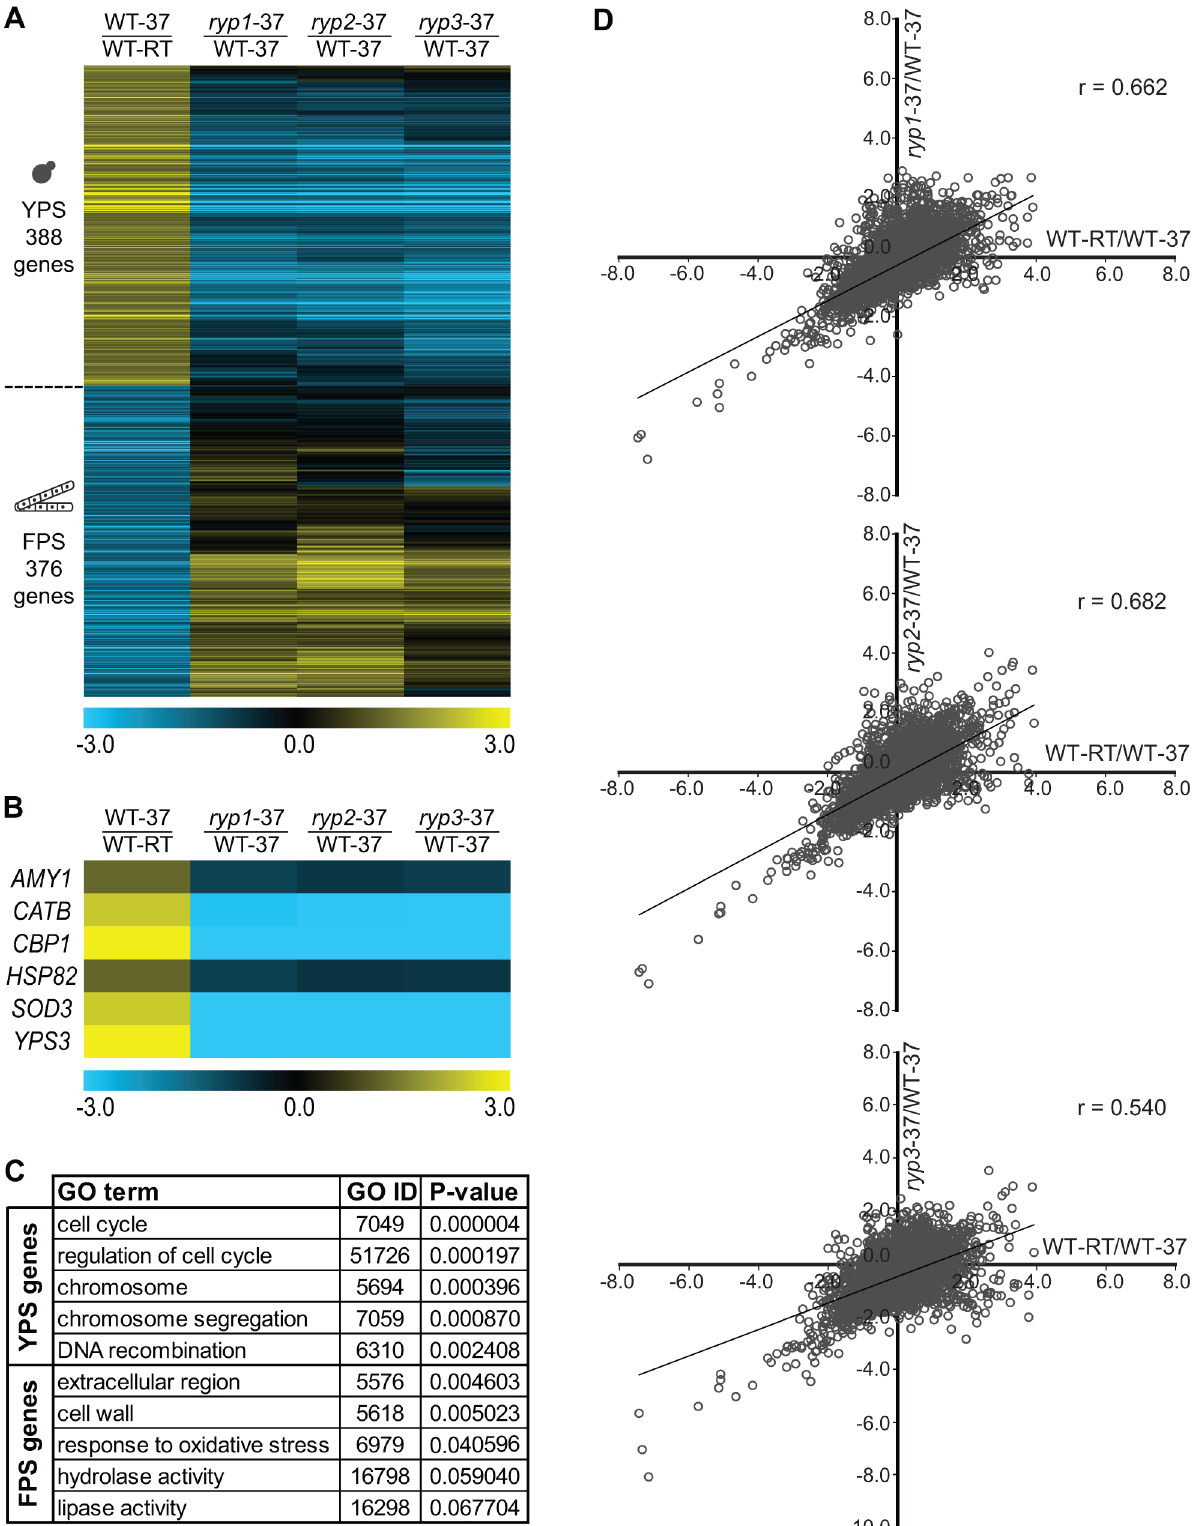
Figure 1. Ryp proteins are required for expression of yeast-phase specific genes. (A) Transcriptional profile comparisons of wild-type cells grown at 37 u C (WT-37), wild-type cells grown at room temperature (WT-RT), and ryp1 , ryp2 , and ryp3 mutants grown at 37 u C represented as a heatmap. For a complete list of YPS and FPS genes see Table S1 (see Materials and Methods for bioinformatics analysis). (B) Select set of YPS genes involved in virulence is shown as a heatmap. Log2-based color scale is shown. (C) Phase-specific genes listed in Table S1 were subjected to analysis for GO term enrichment. Top five GO terms and enrichment p values are shown for both YPS and FPS genes. (D) Correlation between transcriptional profiles of YPS and FPS genes in ryp mutants grown at 37 u C and wild-type cells grown at RT are presented as scatter plots with Pearson correlation coefficients (r). doi:10.1371/journal.pbio.1001614.g001 PLOS Biology | www.plosbiology.org